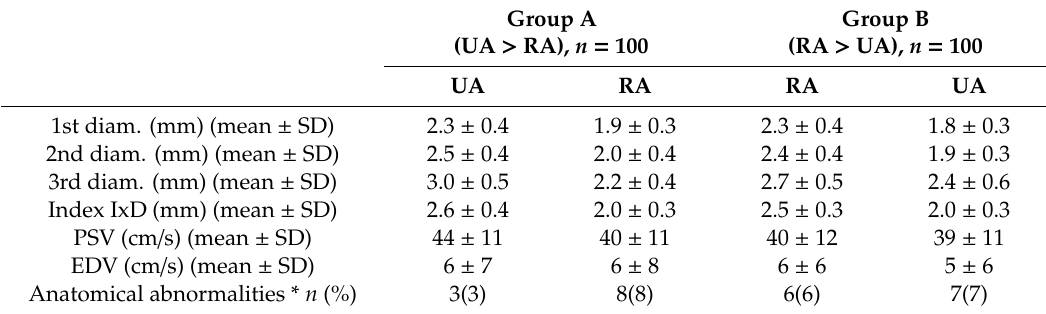
Table 3. Artery diam. and index of domination (IxD) in the pre-US.